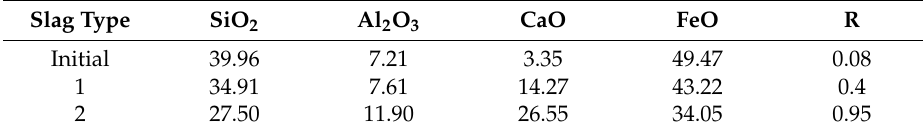
Figure 1. Phase diagram of SiO 2 -Al 2 O 3 -CaO. Table 3. Chemical composition of copper slag (wt. %).